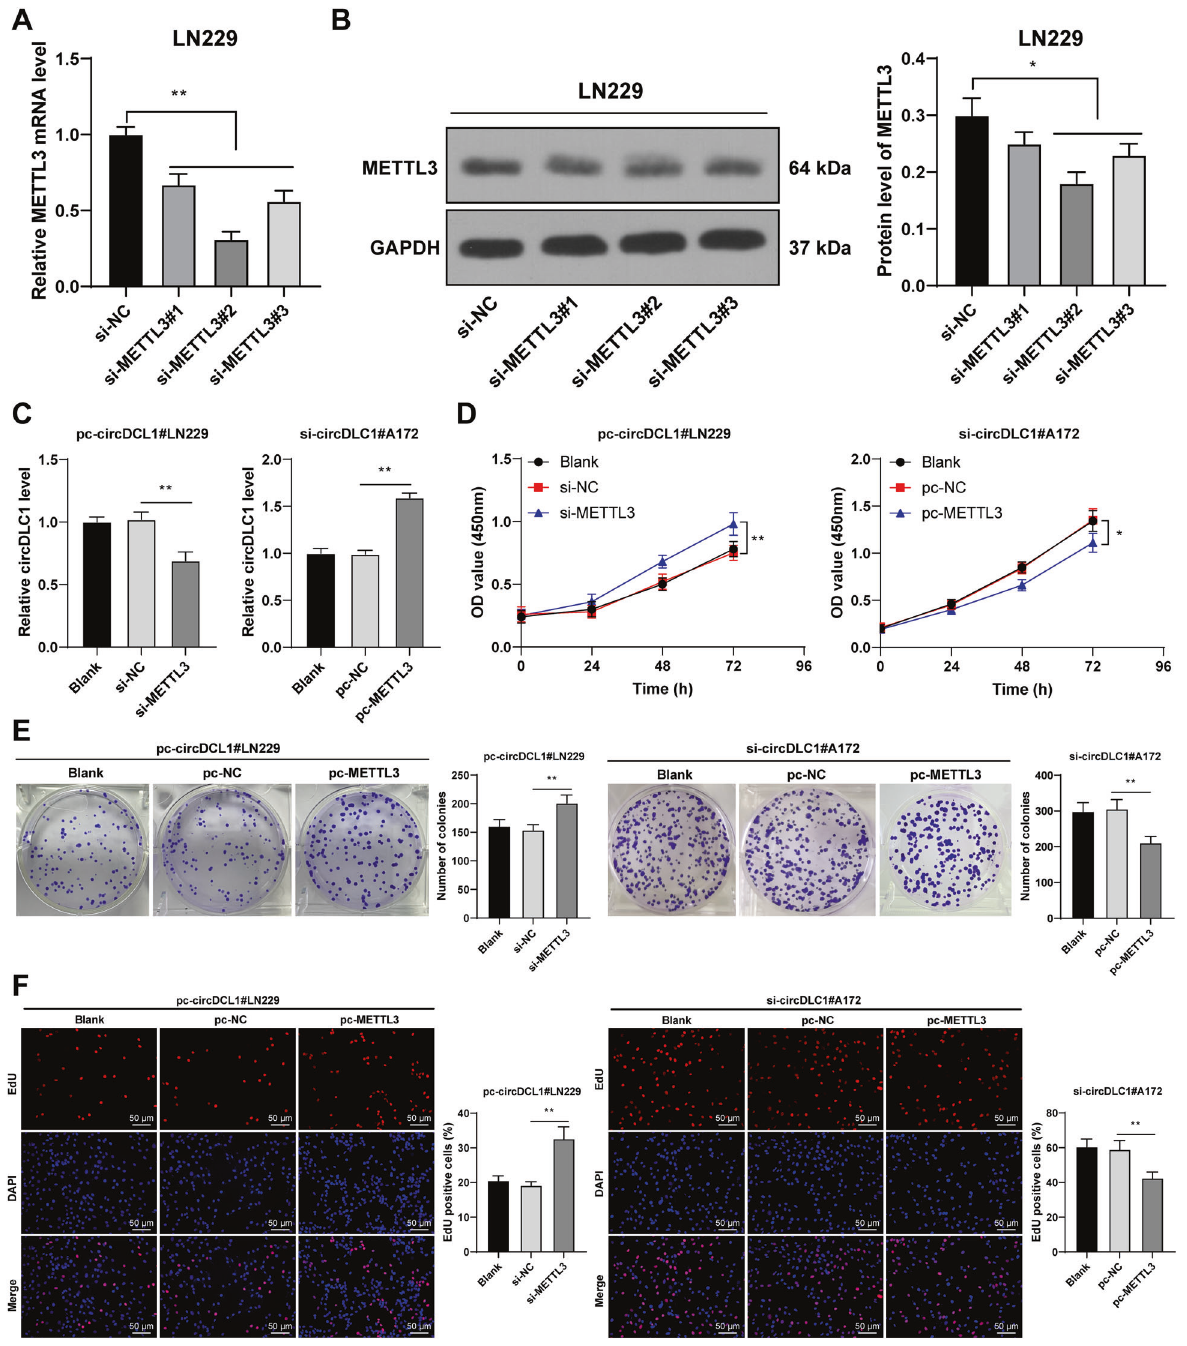
Fig. 4 Overexpression of METTL3 annulled the promoting effect of circDLC1 silencing on glioma cell malignant proliferation. A172 cells were treated with METTL3 overexpression and circDLC1 silencing. METTL3 siRNA (si-METTL3) was transfected into LN229 cells, with NC siRNA (si-NC) as control. A , B METTL3 expression in cells was detected using RT-qPCR ( A ) and western blot ( B ). C circDLC1 expression of cells in the combined treatment group was detected using RT-qPCR. D – F Cell proliferation was measured using CCK-8 assay ( D ), colony formation assay ( E ), and EdU staining ( F ). The cell experiment was repeated three times independently. Data are presented as mean ± standard deviation. Data in panels A – C / E , F were analyzed using one-way ANOVA, and data in panel D were analyzed using two-way ANOVA, followed by Tukey ’ s multiple comparisons test, * p < 0.05, ** p <